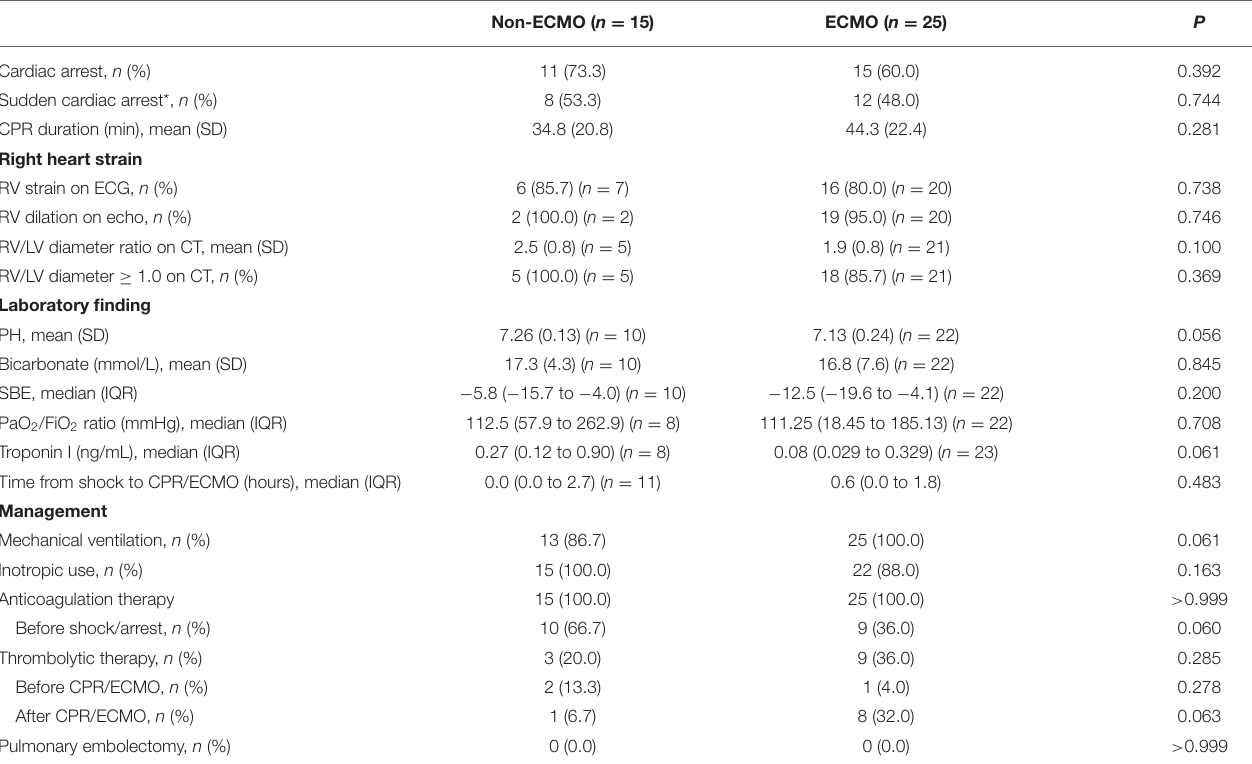
TABLE 2 | Prognostic values and management at the time of shock or cardiac arrest.